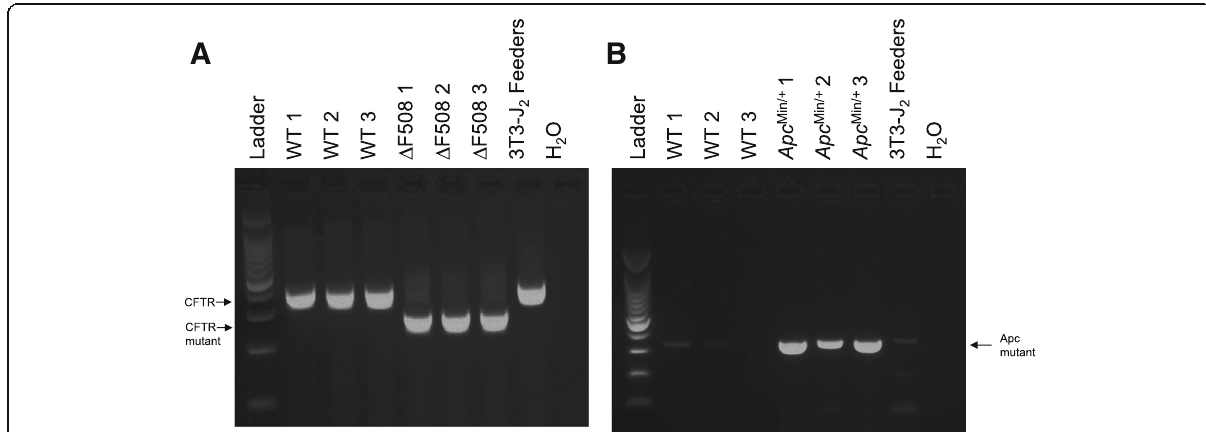
Fig. 2 Small intestinal IEC monolayers from WT, CFTR Δ F508 and Apc Min/+ mice maintain presence of mutant allele across passages. a Genomic DNA isolated from IEC monolayers derived from wild-type (WT) or cystic fibrosis (CFTR Δ F508) mouse models amplified by CFTR primers. WT IEC monolayers and irradiated 3T3-J2 feeders contain the normal length CFTR gene and CFTR Δ F508 IEC monolayers contains the truncated CFTR gene. b Genomic DNA isolated from IEC monolayers derived from WT or intestinal cancer ( Apc Min/+ ) mouse models. IEC monolayers from Apc Min/+ mouse model contains the mutant Apc gene. n =3 individual animals in each genetic mouse model